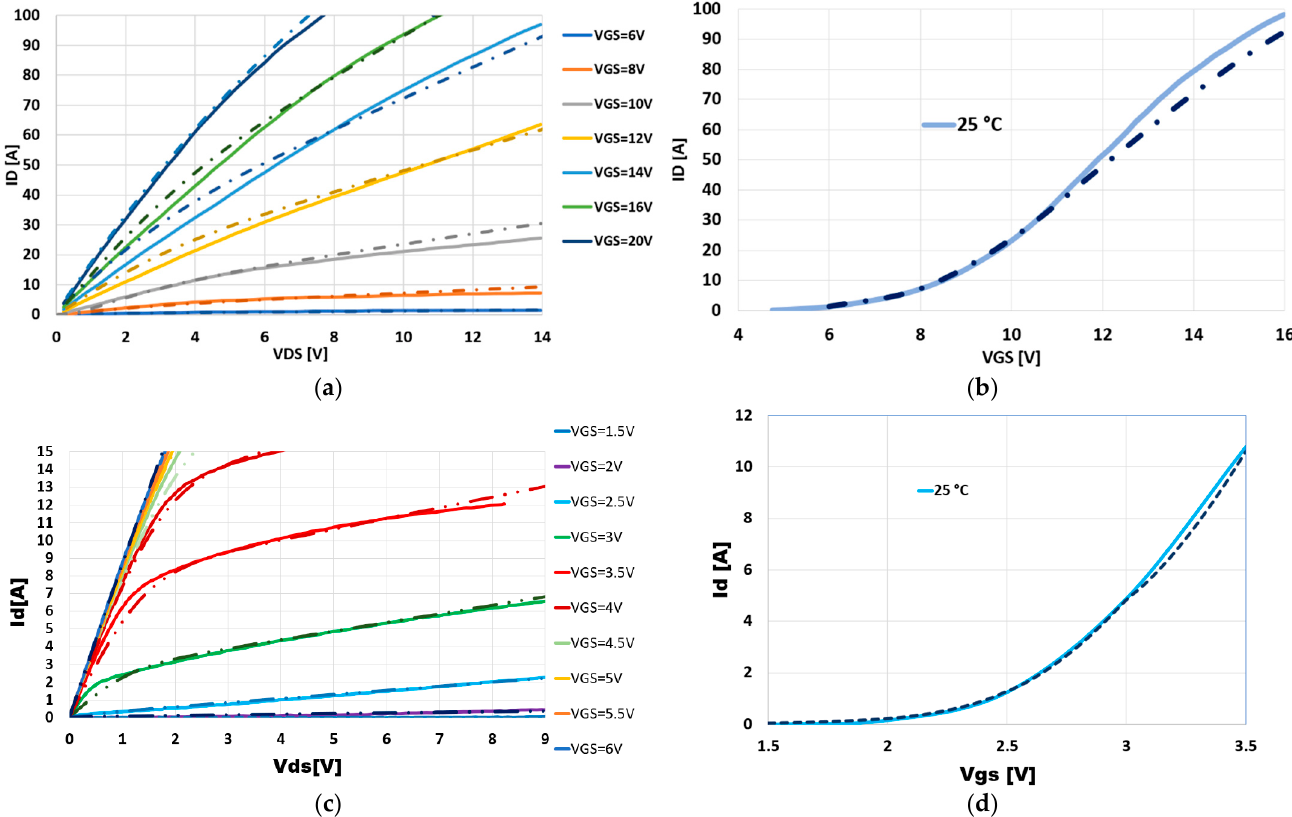
Figure 12. Comparison between target curves (solid lines) and simulated curves (dashed lines): ( a ) output characteristic of SiC MOSFET [78]; ( b ) transfer characteristic of SiC MOSFET [78]; ( c ) output characteristic of GaN HEMT [79]; ( d ) transfer characteristic of GaN HEMT [79].